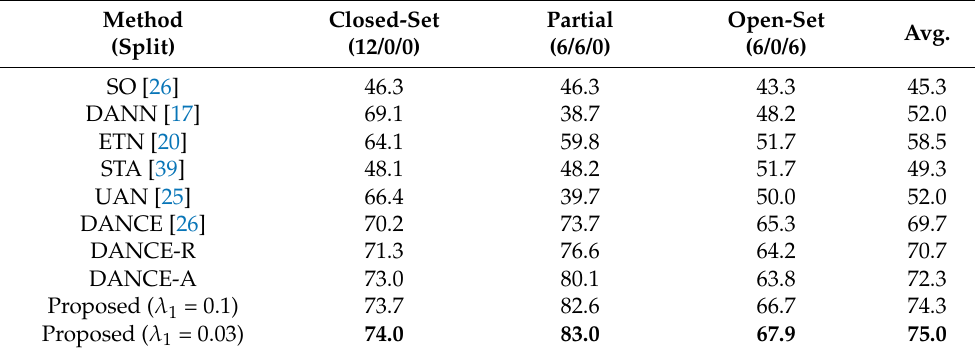
Figure 3. Examples of VisDa-2017. The first row shows synthetic images for the source domain, and the second row shows the real-photographed images. There are substantial variations between the two domains. Table 2. Comparisons of baselines on the VisDA-2017 dataset.